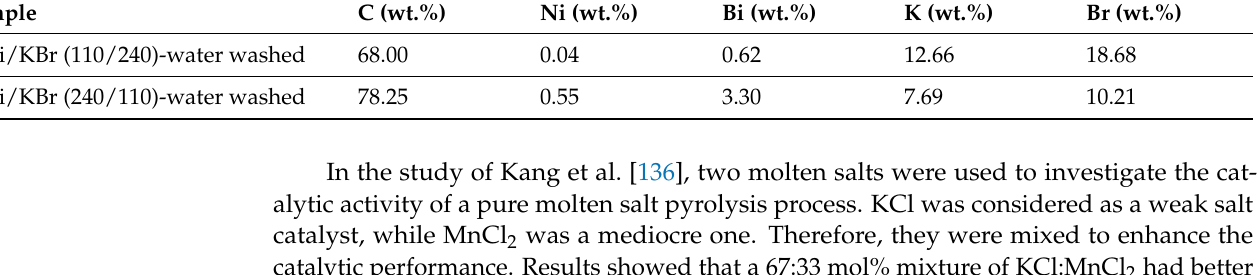
Table 6. XRF analysis of the solid carbon produced in the two-phase methane cracking. Sample C (wt.%) Ni (wt.%) Bi (wt.%) K (wt.%) Br (wt.%) NiBi/KBr (110/240)-water